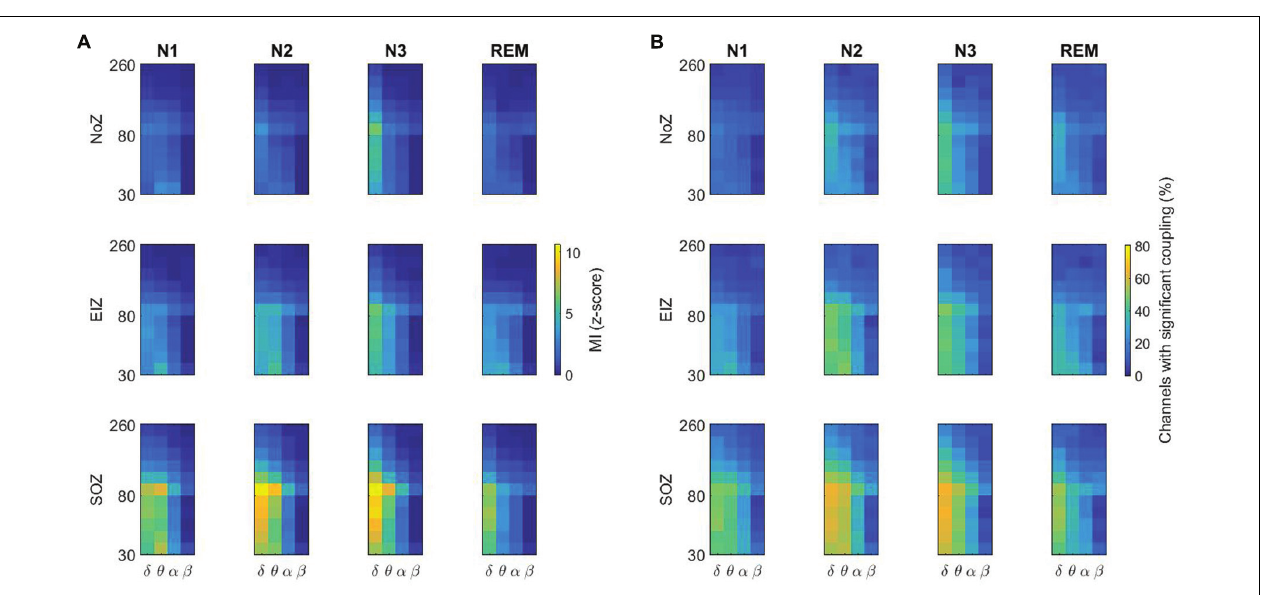
FIGURE 5 | (A) Higher values of PAC in the SOZ compared to the NoZ, and in N3 compared to other stages. The average of PAC in all channels in different sleep stages, (B) Percentage of channels with significant coupling in different frequency pairs. NoZ, normal zone; EIZ, exclusively irritative zone; SOZ, seizure onset zone; MI, modulation